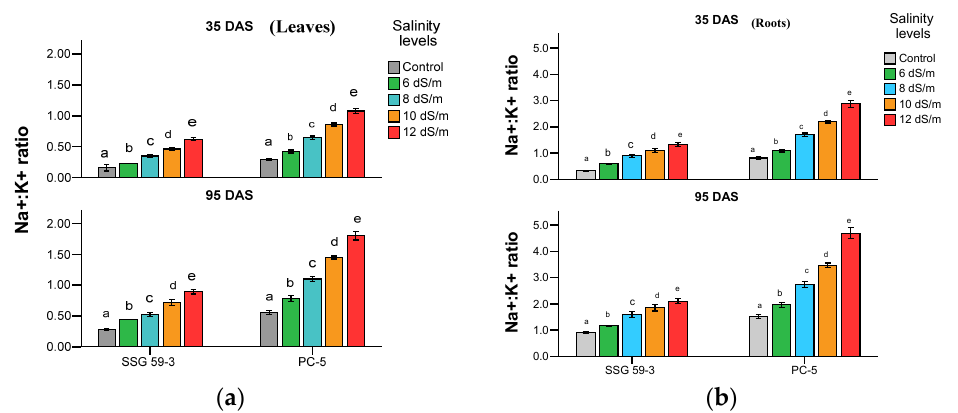
Figure 5. Effect of salt stress on Na + :K + in leaves ( a ), and Na + :K + in roots ( b ) of sorghum genotypes at 35 and 95 DAS. Post hoc comparisons of the means were performed using Tukey’s HSD test at p < 0.05; different letters ( a–e ) indicate significant differences among treatments within each genotype.